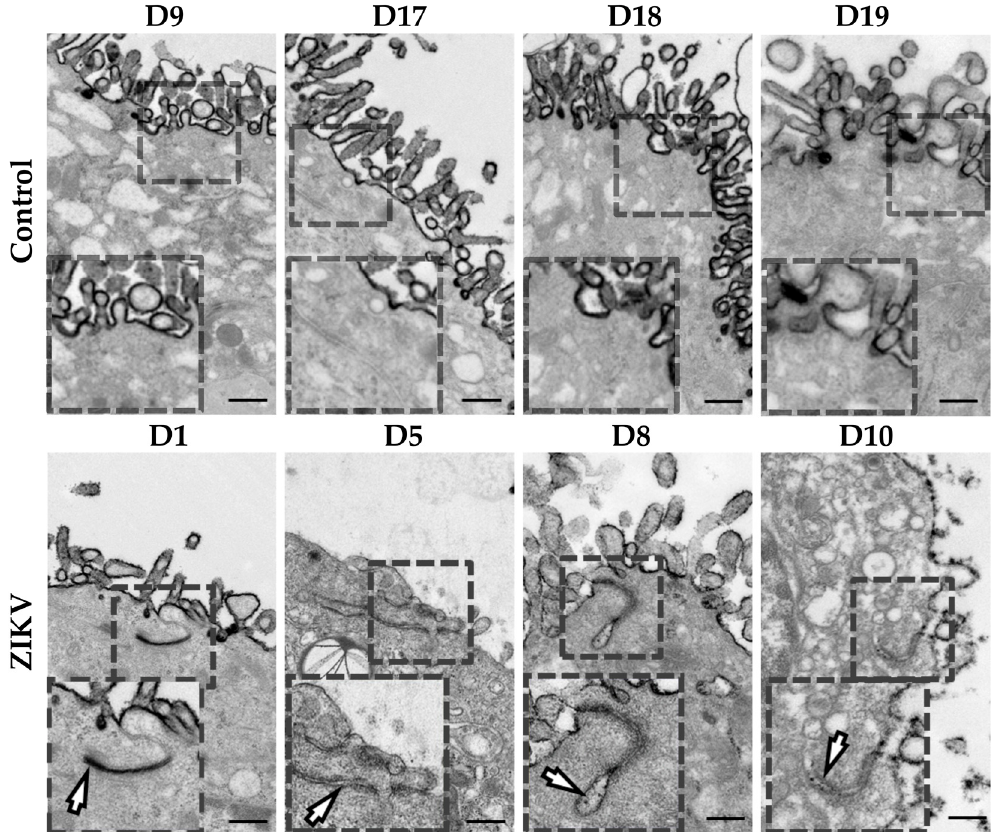
Figure 3. The STB in the placentae of ZIKV-infected women was permeable to ruthenium red. Placental tissue was fixed and processed for TEM in the presence of ruthenium red. Ruthenium red staining in the paracellular pathway (arrows). Bar, 1 µm.